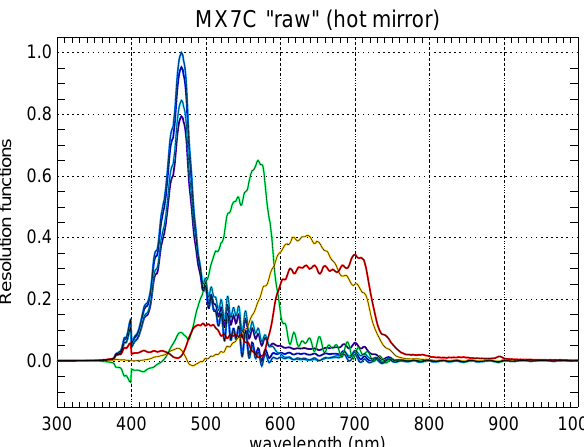
Figure 13. Resolution/window functions ( A ) for ICX429AKL in “raw” mode with smoothing µ = 1 and retrieved wavelengths of 391.4 (dark blue), 427.8 (blue), 470.9 (light blue), 486.1 (cyan), 557.7 (green), 630.0 (orange), and 777.7nm